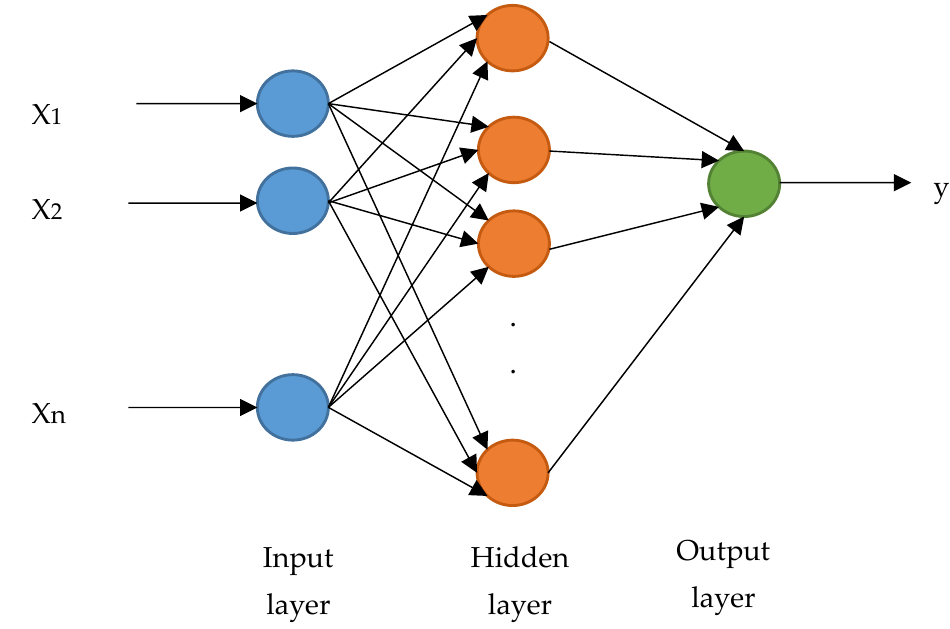
Figure 4. Artificial neural network architecture (binary classification). Table 1. The hyper - parameters used in the proposed detection model. Hyper-Parameters